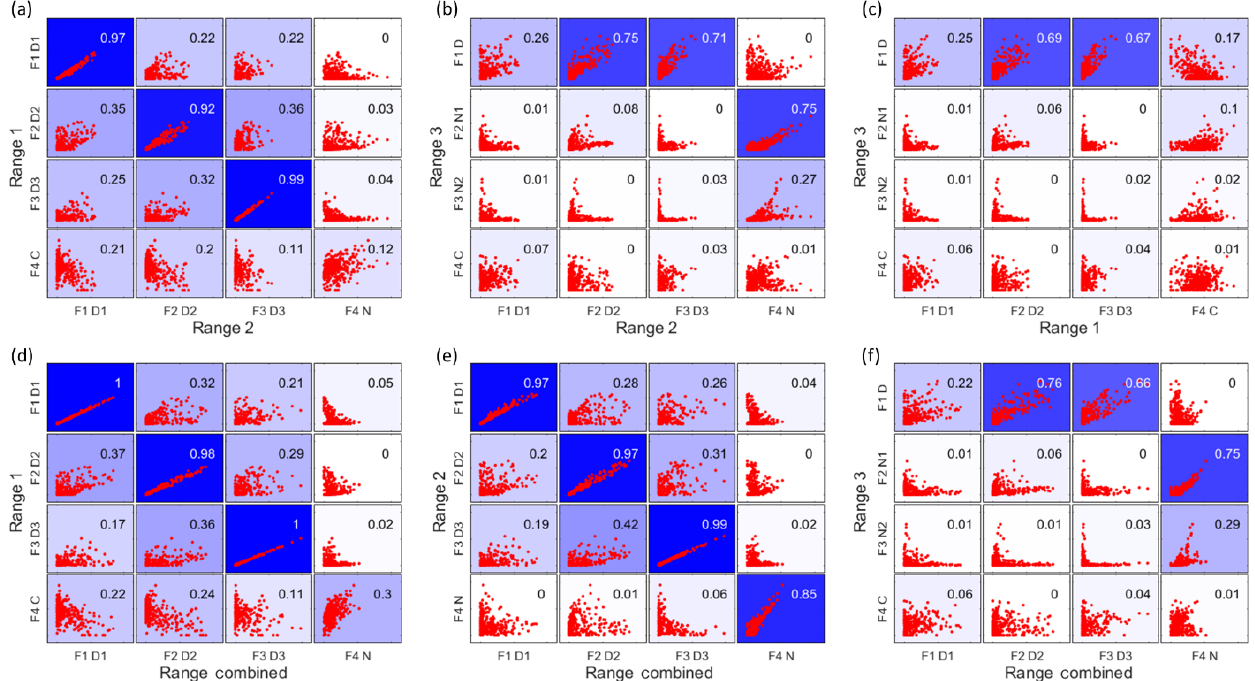
Figure 6. Time series correlations among Range 1, Range 2, Range 3 (a–c) , and between the first three ranges and the Range combined (d–f) . The abbreviations for different factors are the same as in Table 1, with F for factor, D for daytime, N for nighttime, and C for contamination, e.g. F1D1 for factor 1 daytime 1. The coefficient of determination, R 2 , is marked in each subplot by a number shown in the right upper corners and by the blue colors, with stronger blue indicating higher R 2